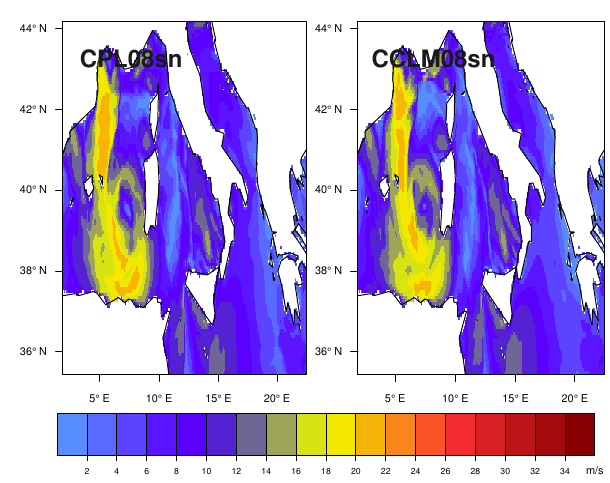
Figure 5. ME08; 10m wind speed (ms − 1 ) in the coupled and atmosphere-only (0 . 08 ◦ ) with spectral nudging simulations, on 7 October 1996 at 18:00UTC.